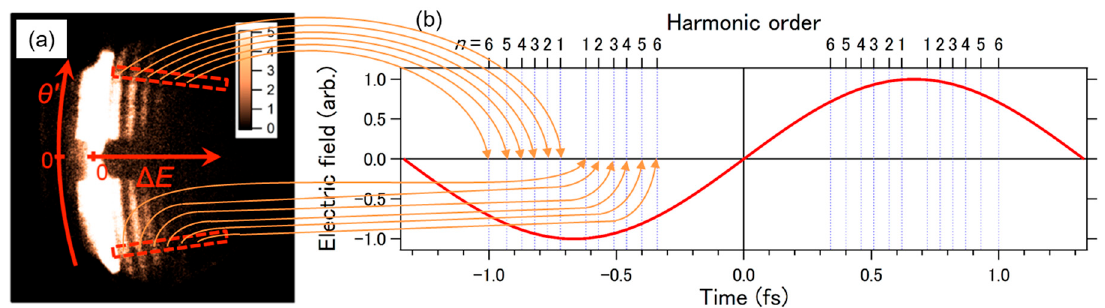
Figure 9. ( a ) Energy-resolved angular distributions of scattered electrons recorded when 1 keV electrons are scattered by Xe atoms in an intense laser field ( λ = 800 nm, I = 1.5 × 10 12 W/cm 2 , Δ t = 970 fs) [66]. ( b ) Assignments of collision times for LAES processes yielding the scattering angles of ±11.8°. The red solid curve is the electric field of the laser field and the blue dotted vertical lines are the collision times for the respective harmonic orders, n = Δ E /( ħω ).